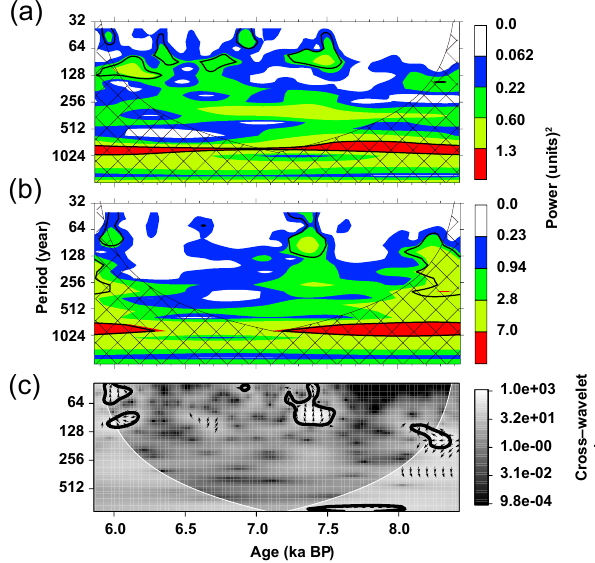
Figure 10. Continuous wavelet transform of (a) assemblage-based summer SST and (b) Mg / Ca-based upwelling SST. The 10% sig- nificance level against red noise is shown as black contour lines. (c) Cross-wavelet transform (XWT) of the trend-removed Mg / Ca- based and assemblage-based SST time series. The 5% significance level is shown as thick contours. Relative phasing of both records is indicated by arrows. Arrows within the significant intervals point mostly upwards, which indicates a consistent phase shift of both records by 90 or 270 ◦ , respectively, of assemblage-based SST rela- tive to Mg / Ca-based SST. The cone of influence, where edge arte- facts might be introduced, is indicated by hatching and white shad- ing,